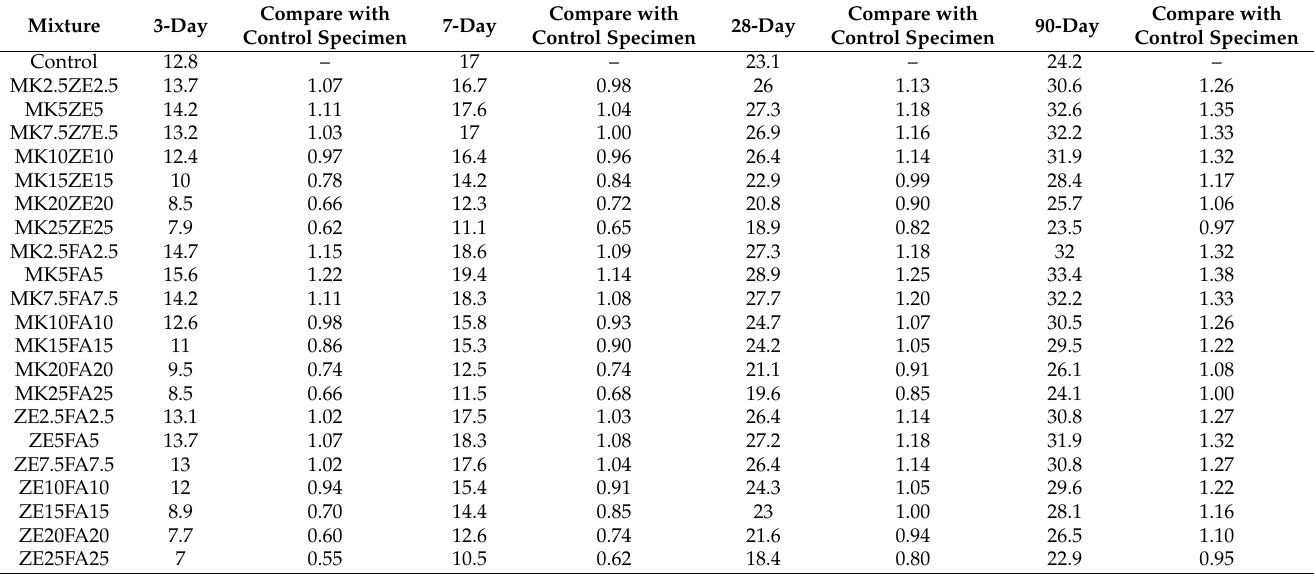
Table 8. Compressive strength of specimens [All units are in MPa].